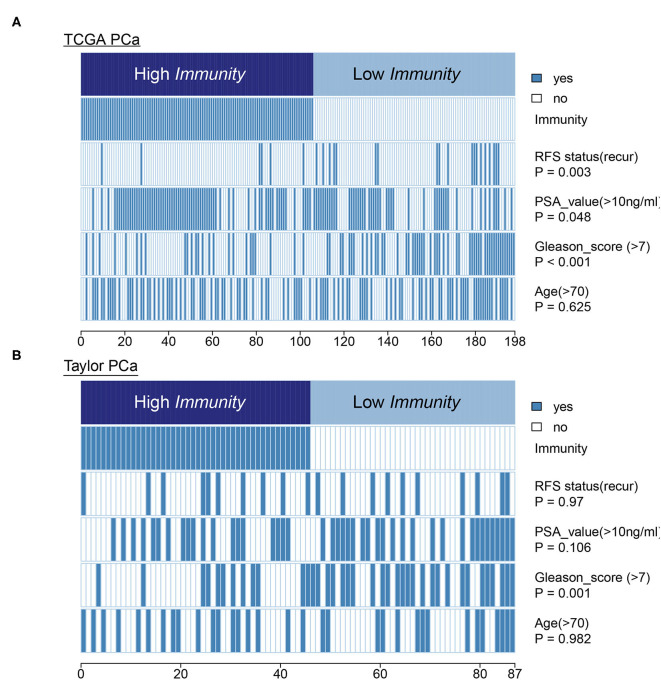
Comparing PSA value, Gleason score, and age between the immune-H and immune-L PCa subsets. Statistical significance was performed using the Chi-square test. The heatmap illustrates the association of different clinical characters with PCa subsets. (A,B) TCGA PCa and Taylor, respectively.